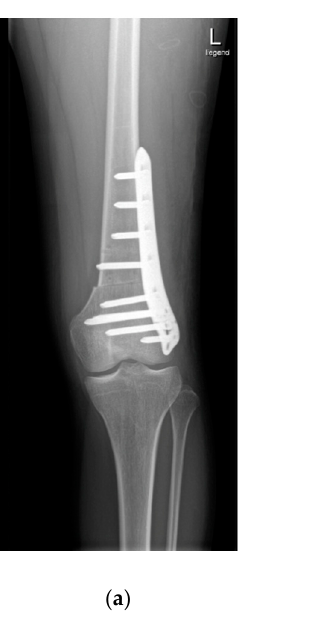
Figure 2. Anteroposterior ( a ) and sagittal ( b ) radiographs showing the situation after supracondylar rotational